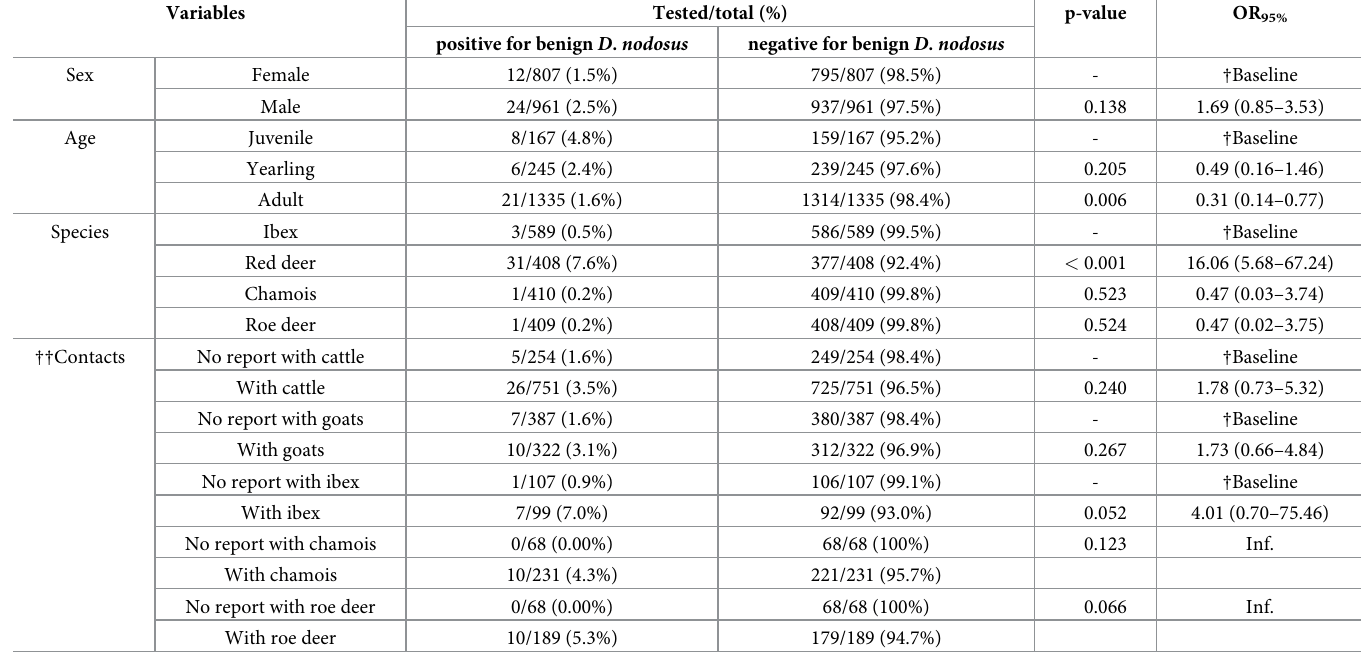
Table 3. Univariable risk factor analysis for presence of benign Dichelobacter nodosus on wild ruminant feet. Variables